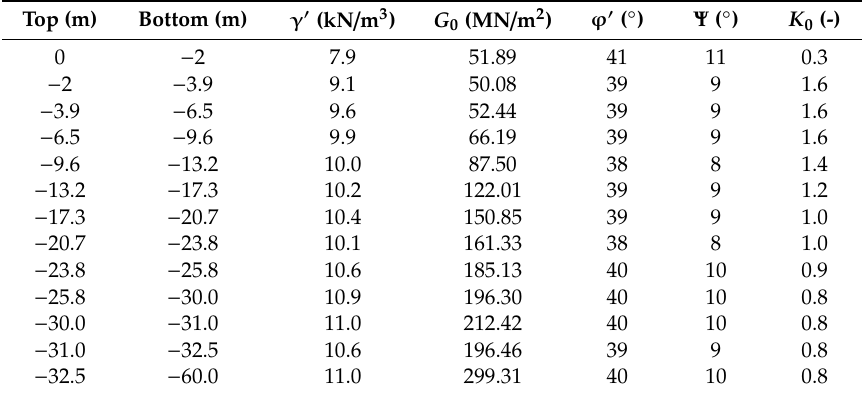
Table 5. Soil data of the application case.